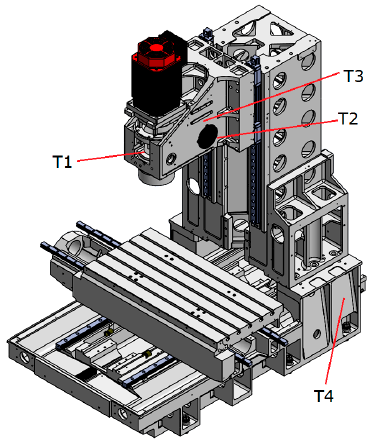
Figure 6. Schematics of the locations of temperature sensors.